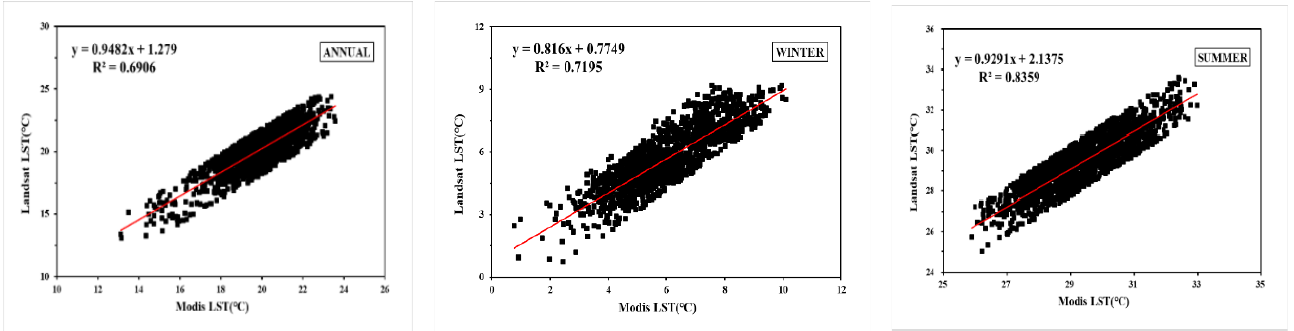
Figure 3. Accuracy of inversion temperature compared to MODIS temperature products (ANNUAL for year-round results, R 2 0.6906; WINTER for winter results, R 2 0.7195; SUMMER for summer results, R 2 0.8359).